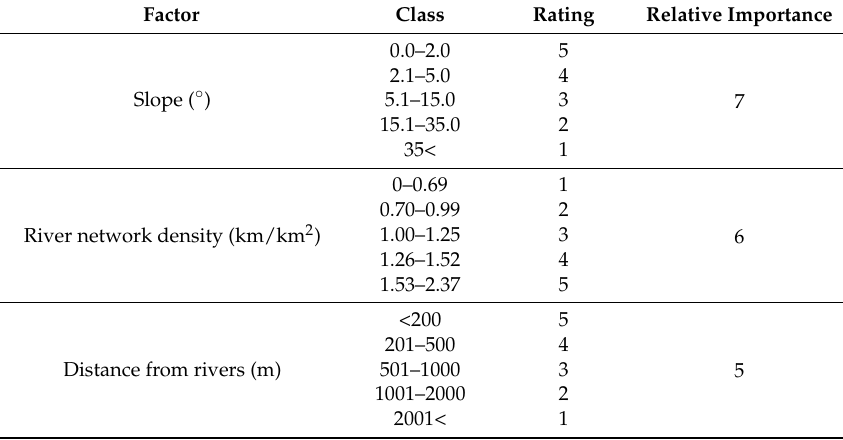
Figure 4. Flood conditioning factors: ( a ) curve number, ( b ) lithology. Table 2. Classes of conditioning factors, estimated ratings, and relative importance.